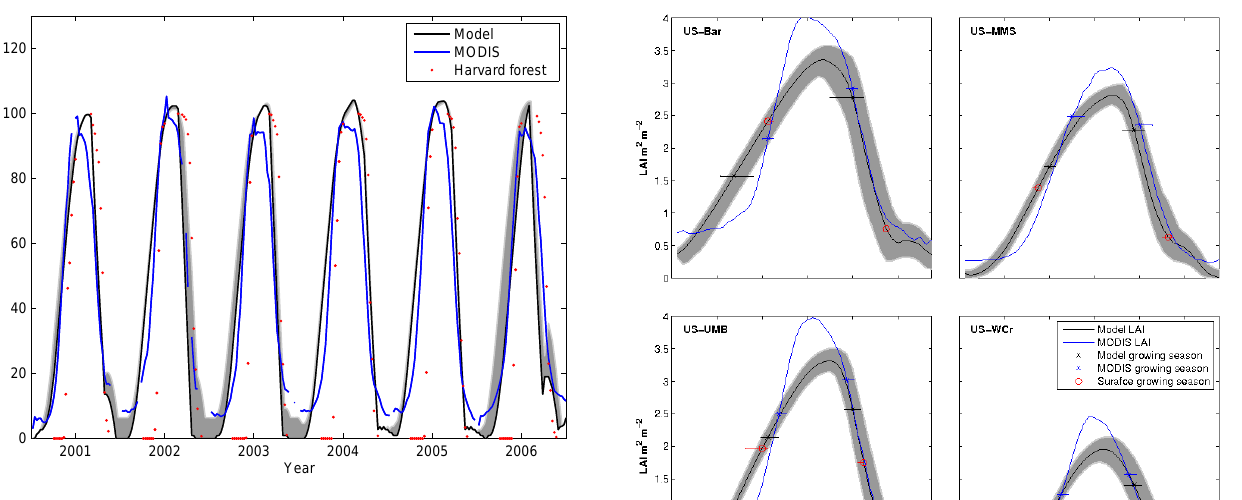
Fig. 8. Percent canopy development as shown by the model (black), MODIS data (blue) and ground observations (red dots) at the Har- vard Forest site (US-Harv, 42.53 ◦ N, 72.18 ◦ W) for the period 2001–2006. Shaded grey areas represent 95% confidence intervals calculated from the parameter posterior distribution.